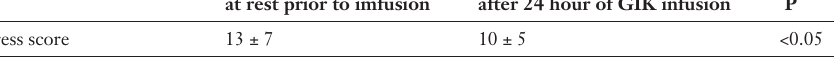
Result of myocardial scintigraphy with 99mTc sestamibi at rest before and after 24 hour of GIK- infusion (values are mean ± S.D.).